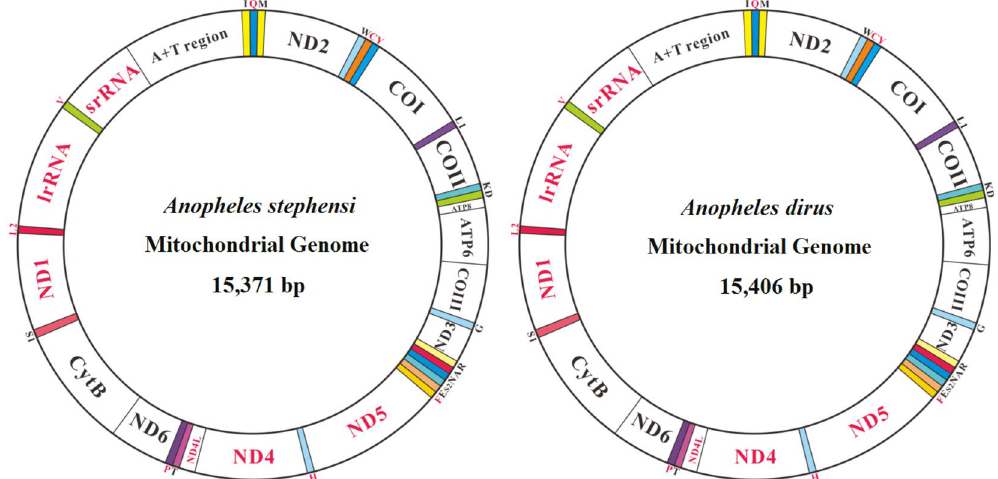
Figure 1. Mitochondrial genome structure of Anopheles stephensi and An. dirus . The color-filled blocks indicate tRNAs, while the un-filled white blocks denote protein-coding genes, rRNA and control regions. The protein- coding genes, rRNA and control regions with black name are located on majority strand, whereas those with red names are on minority